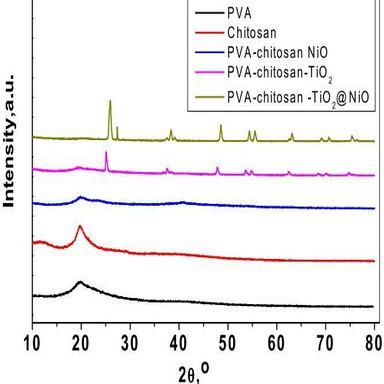
XRD patterns of PVA, chitosan, PVA-chitosan–TiO2, PVA-chitosan–NiO, and PVA-chitosan TiO2@NiO films.